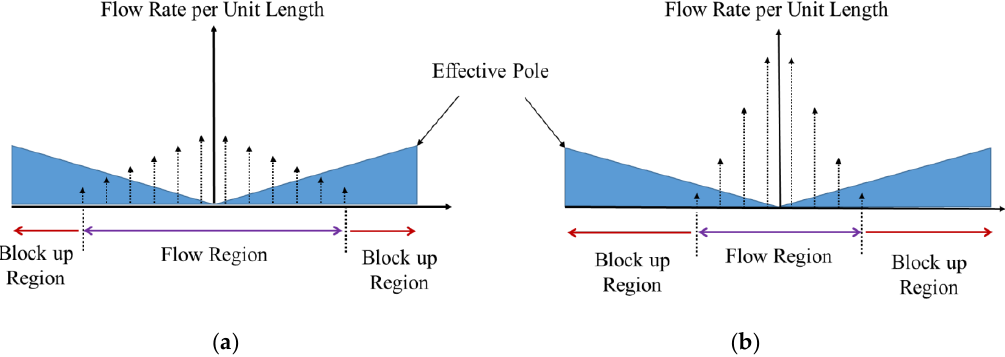
Figure 5. Flow rate profile through the main orifice of MRD-PSF: ( a ) in low magnetic field and ( b ) in high magnetic field.